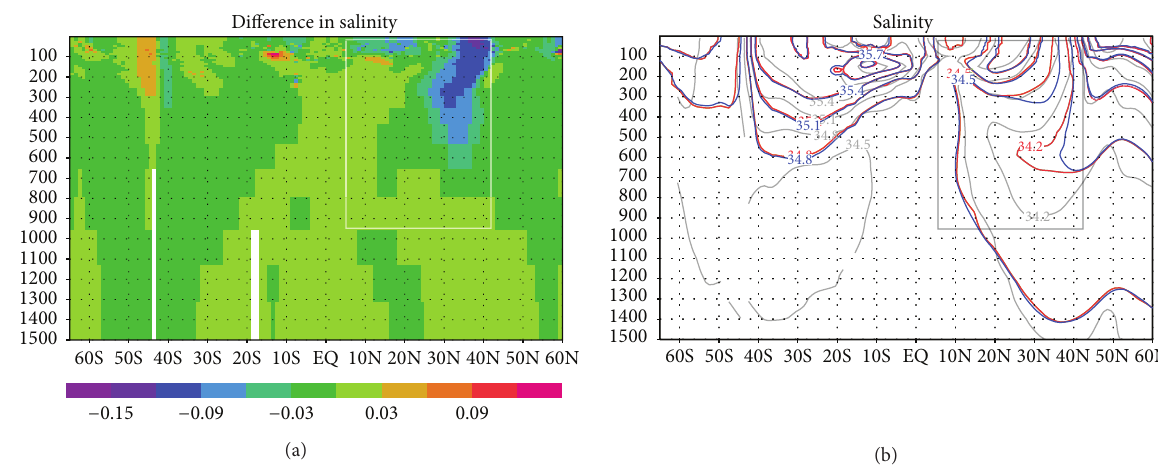
Figure 7: (a) Difference in salinity during 2001–2007 between GY and CT cases in a 1500 m vertical cross section along longitude 180 ∘ . (b) Mean salinity for GY (red curves) and CT (blue) cases in a 1500 m vertical cross section along longitude 180 ∘ . Gray curves are mean values from the MOAA GPV observation dataset